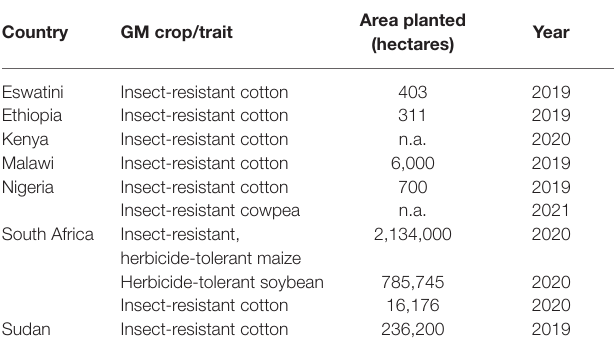
TABLE 1 | GM crop cultivation in sub-Saharan Africa. Country GM